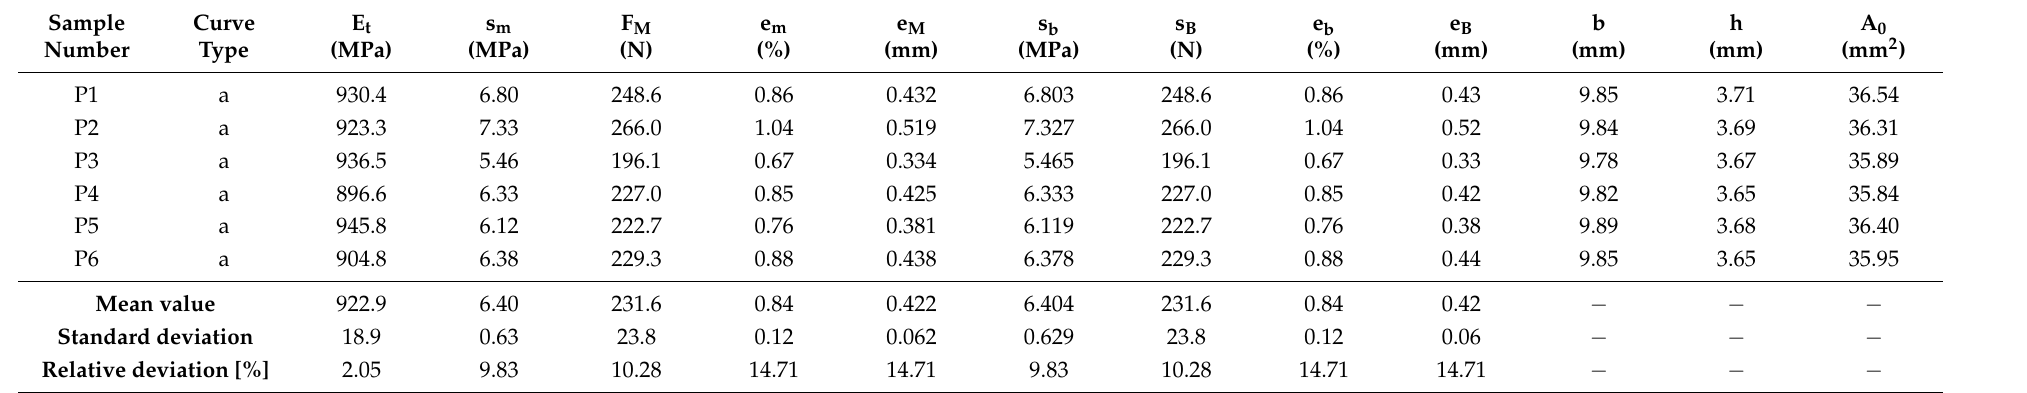
Table A45. Results of the tensile tests of